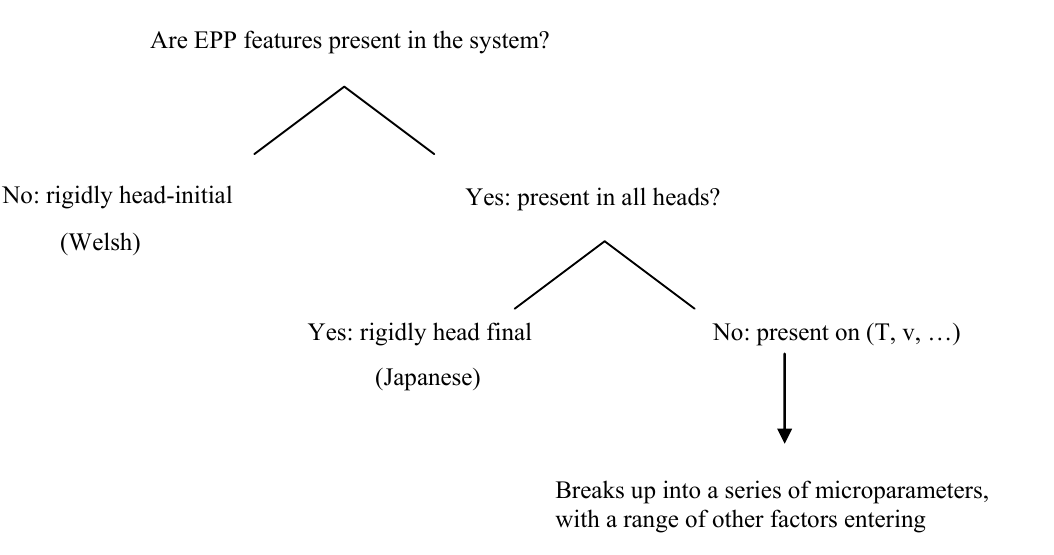
Figure 3: A hierarchical network of parameters. The scheme, adapted from Holmberg and Roberts, represents the authors’ proposal regarding the so-called Head Parameter and relies on conventions of markedness and other details that are not relevant